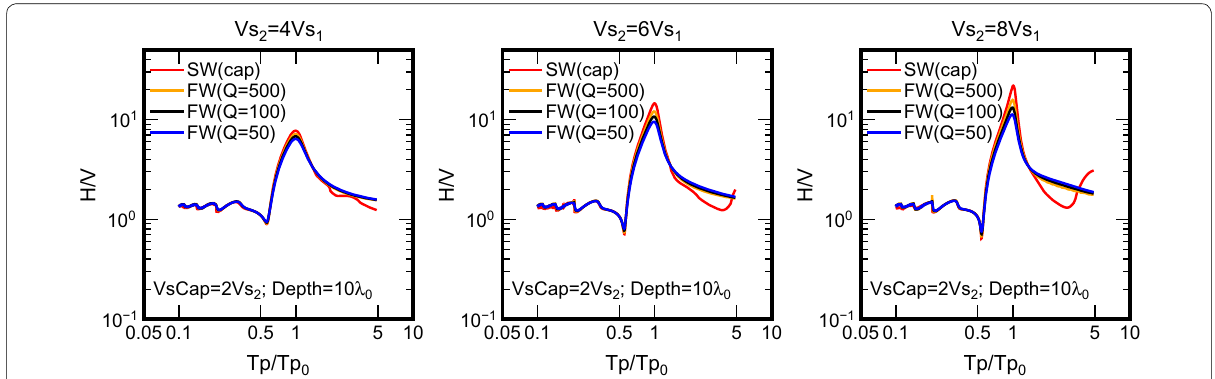
Fig. 6 FW H / V s of target two‑layered media with different impedance ratios (Left: V s2 Q values (Q 500, orange; Q =